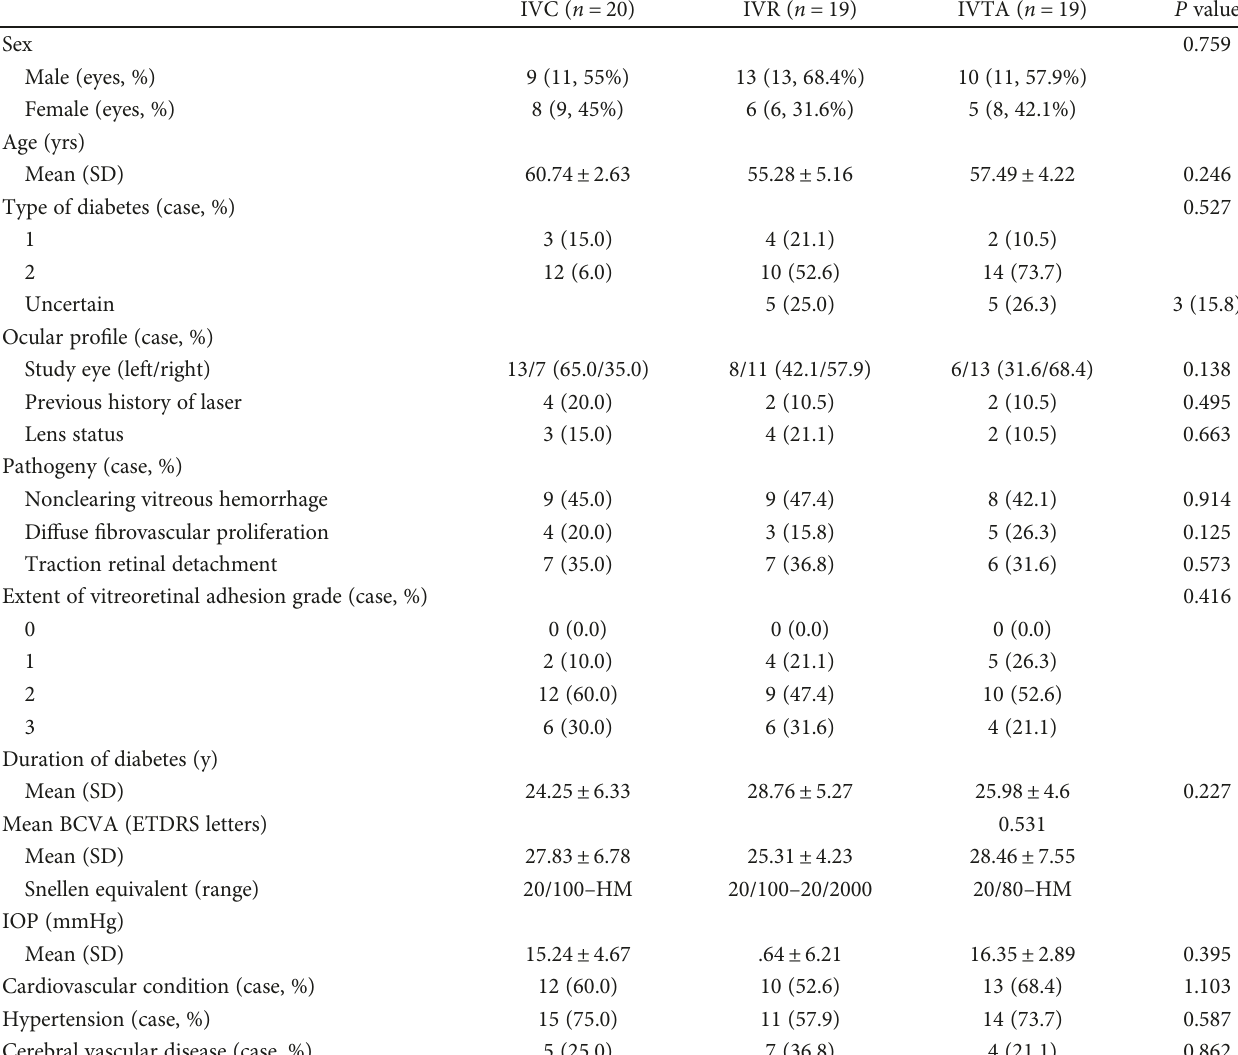
Table 1: Baseline characteristics of participants with or without conbercept